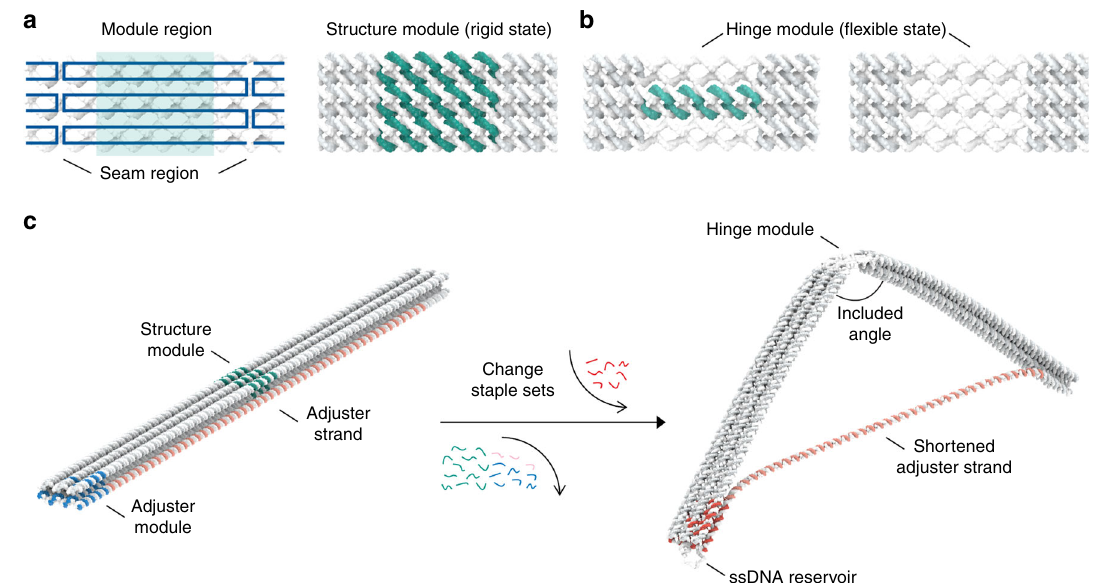
Fig. 1 Schematic illustration of the modular design. a Scaffold strand is represented as blue lines (simpli fi ed to show its pathway clearly). Scaffold crossovers are aligned at the cross-section, and these sections are located at regular intervals. A module region, shown as green-shaded area, is located in between the scaffold crossover seams. Basically, all the helices of the structure module are double-stranded and all possible staple crossover positions are connected. b The hinge module can be made by removing the staples in the structure module, while unbound scaffold ssDNAs at the module remained at the cross-section. By controlling the number of dsDNA and staple crossovers, bending stiffness of the hinge module can be adjusted. Seam region maintained with full connection throughout the modi fi cation in order to ensure structural stability. c A 12-helix honeycomb-latticed bundle design to illustrate the method of controlling the shape of the structure. To make a bent structure from the straight one, staples of the structure module were removed and the adjuster module component was changed in order to make a shorter adjuster strand. Excessive strut staples were